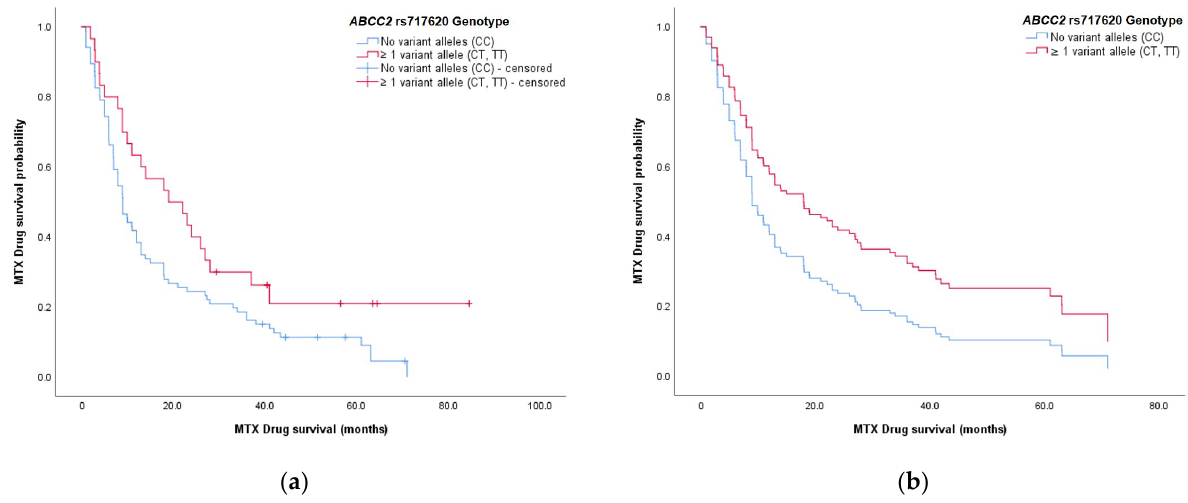
Figure 2. Methotrexate drug survival curves stratified according to the ABCC2 rs717620 genotype: ( a ) drug survival curves obtained by Kaplan–Meier survival analysis; ( b ) theoretically predicted survival curves obtained by multivariate Cox regression analysis. Both of the survival plots show a higher probability of longer drug survival for patients who carry at least one variant allele T in ABCC2 (red), compared to the wild-type genotype (blue).